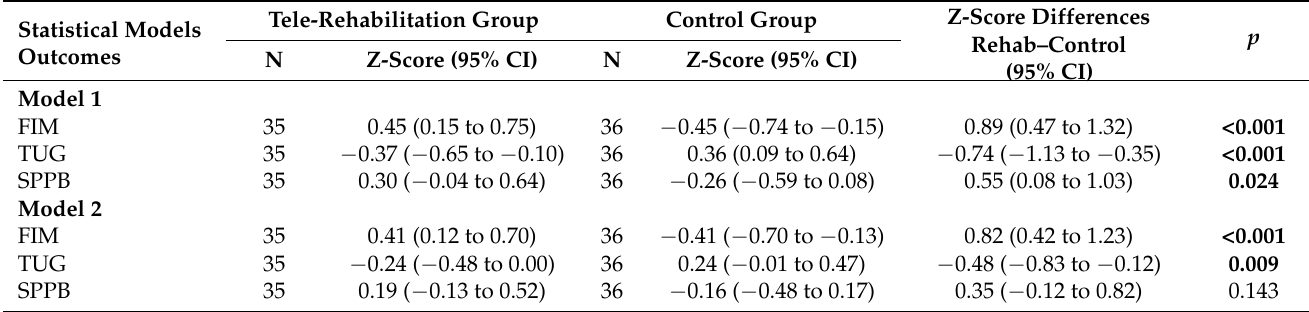
Table A2. Intervention effects of the ActiveHip project.